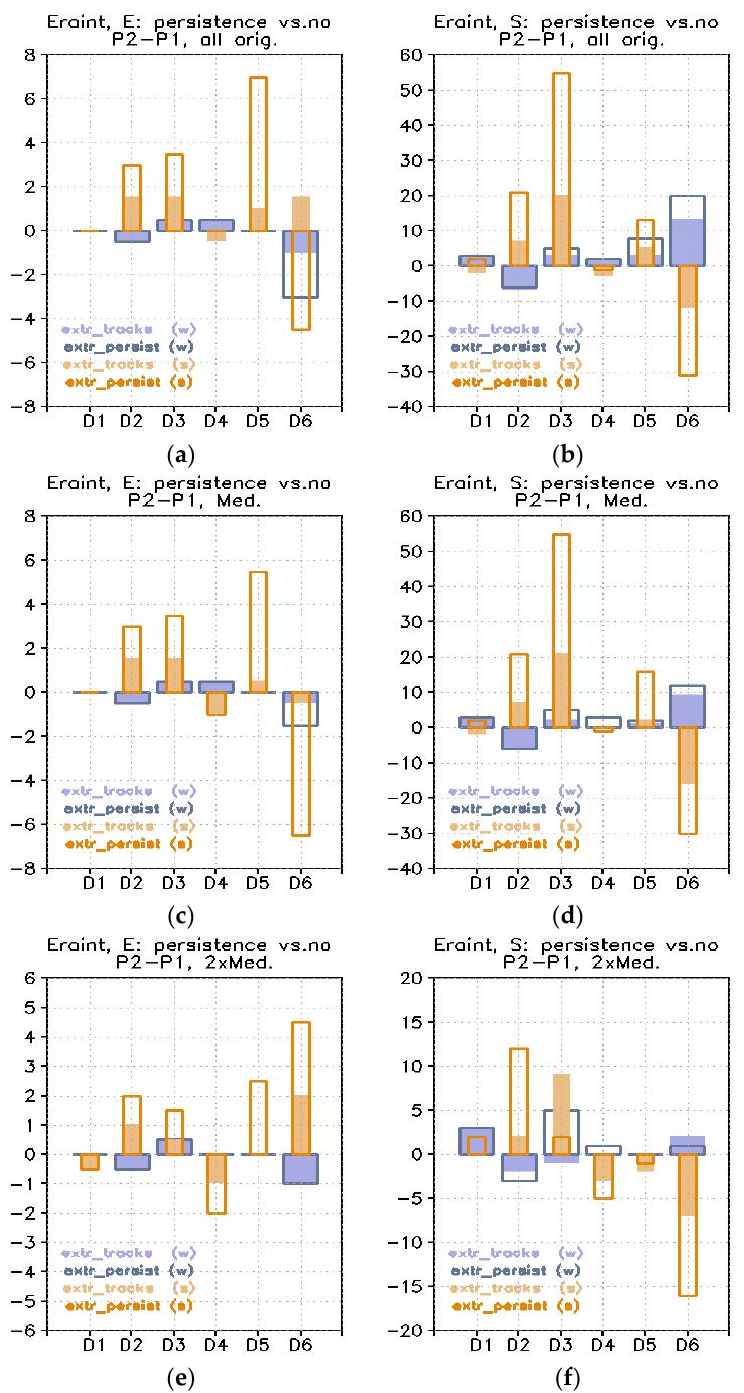
Figure 6. Changes in the persistence of extreme cyclones per class and origin. Origins are in “EU” ( a , b ), “Med” ( c , d ) and “2xMed” ( e , f ) domains; extreme cyclone classes are “E” ( a , c , e ) and “S” ( b , d , f ). Shaded bars show: the P2–P1 differences between the number of distinct extreme cyclones tracks in Di (i = 1,6) and the contour lines show: the P2–P1 differences between the number of extreme events in Di (allowing for the same cyclone in a track to further deepen or remain extreme in the same Di for following time steps (6 h)); colors show differences in P2–P1 for summer (orange) and winter (blue).